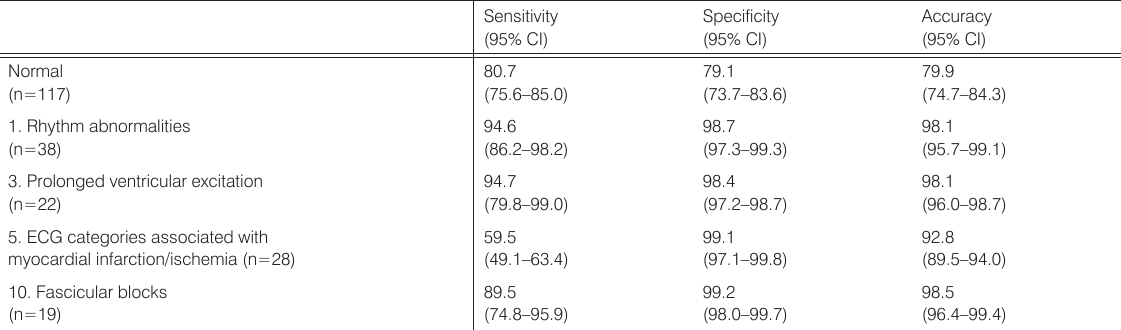
Table 2. Sensitivity, specificity and accuracy of GP readings after codification by identification categories with 95% confidence intervals (95%